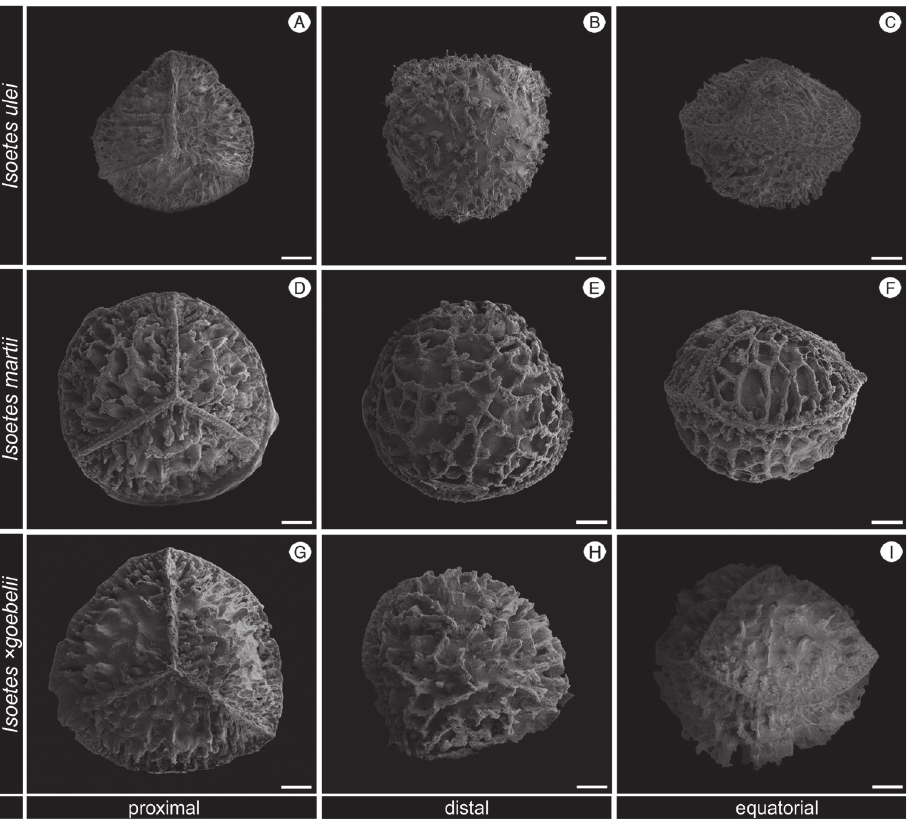
Figure 3. SEM images of the megaspore of Isoetes ulei (Ule 3533, HBG), I. martii (Pereira 720, UPCB) and I. ×goebelii (Pereira 718, UPCB). A–C Megaspore of I. ulei A Proximal view B Distal view C Equa- torial view D–F Megaspore of I. martii D Proximal view E Distal view F Equatorial view G–I Megaspore of I. × goebelii G Proximal view H Distal view I Equatorial view. All scale bars = 100